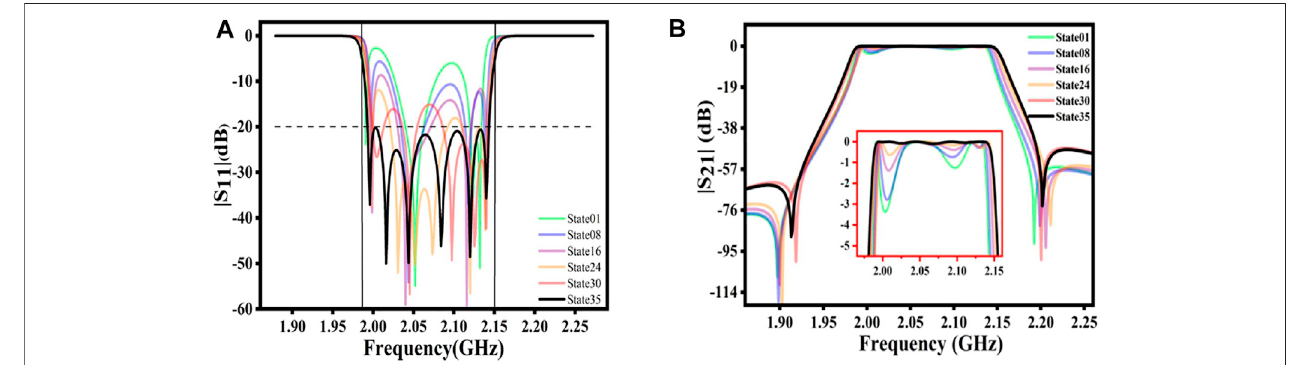
FIGURE 5 | Simulated response of the sixth-order cavity fi lter in different tuning